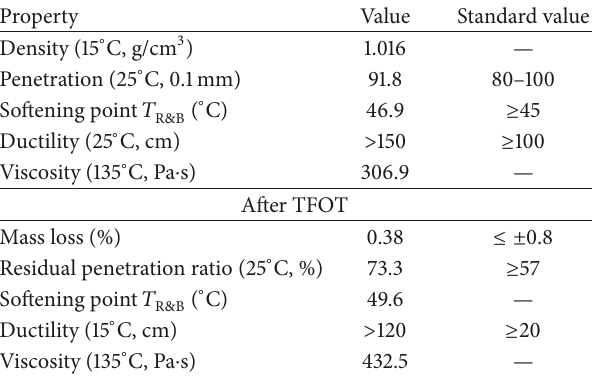
Table 1: Physical properties of neat asphalt.